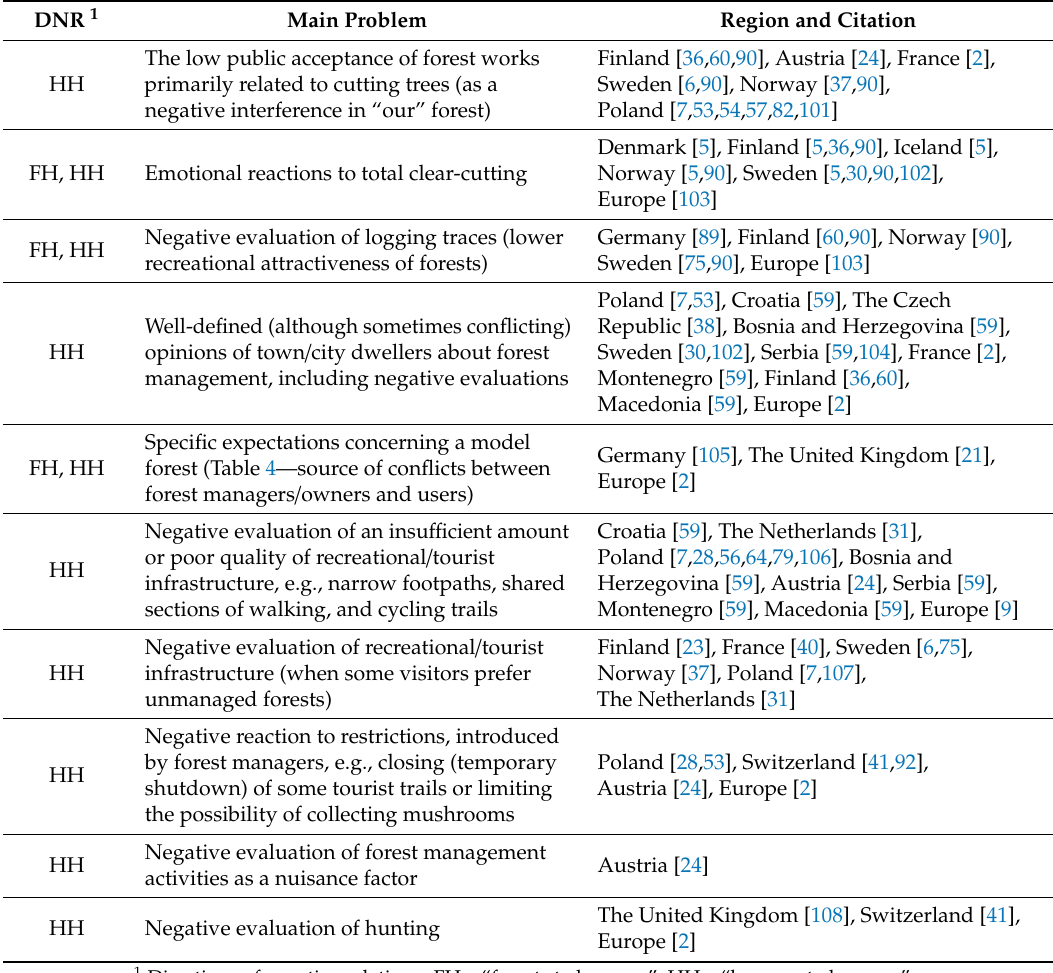
Table 2. Negative social reception of forest works in urban and suburban